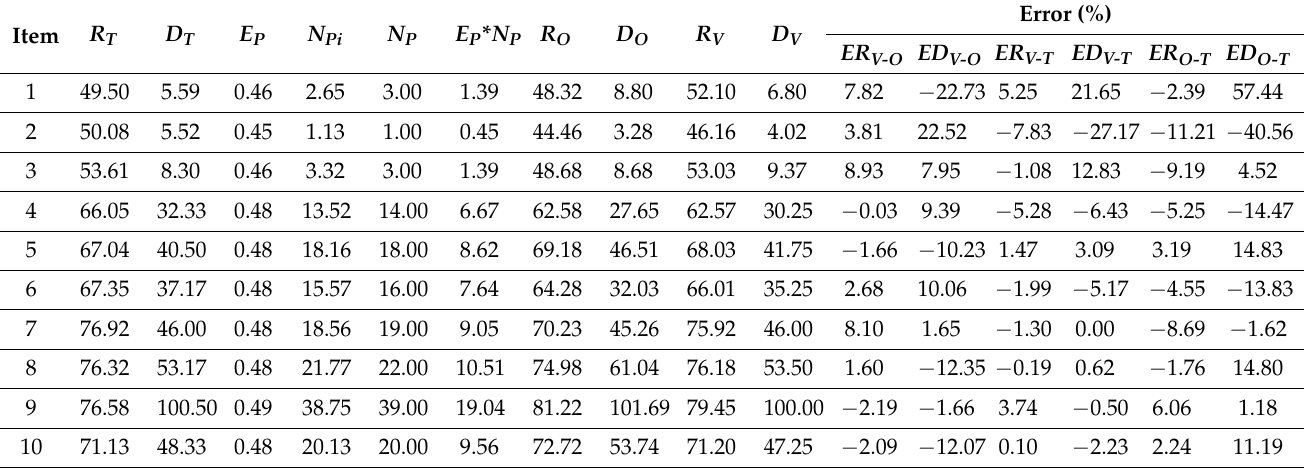
Table 8. Parameter verification results.